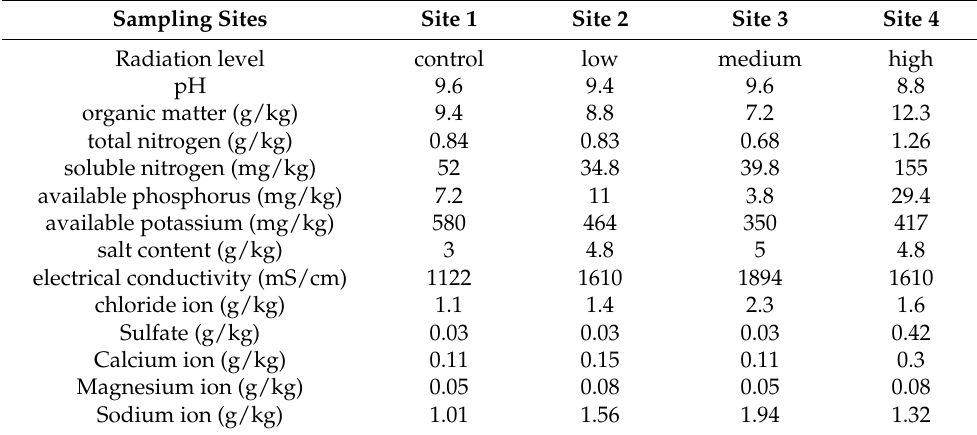
Table 1. Radiation levels and geochemical characteristics of sampling